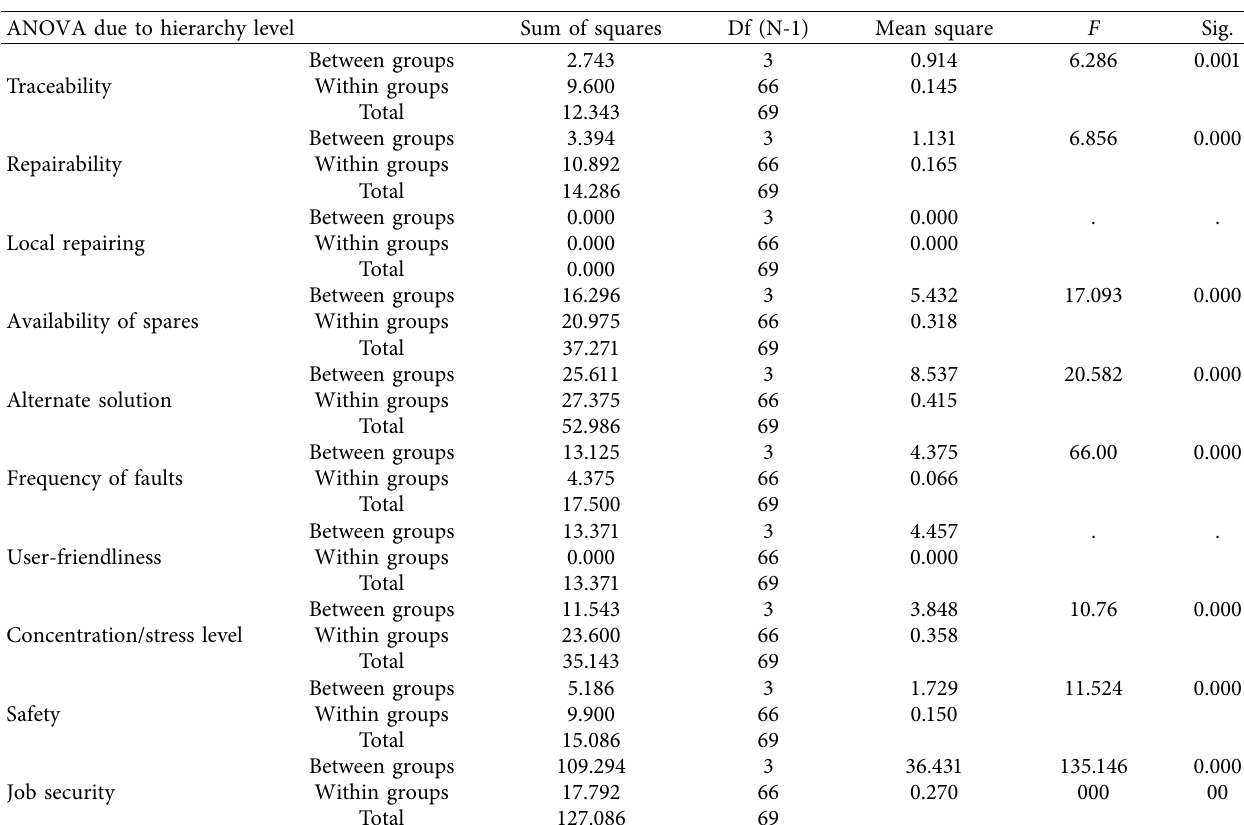
Table 26: ANOVA due to hierarchy